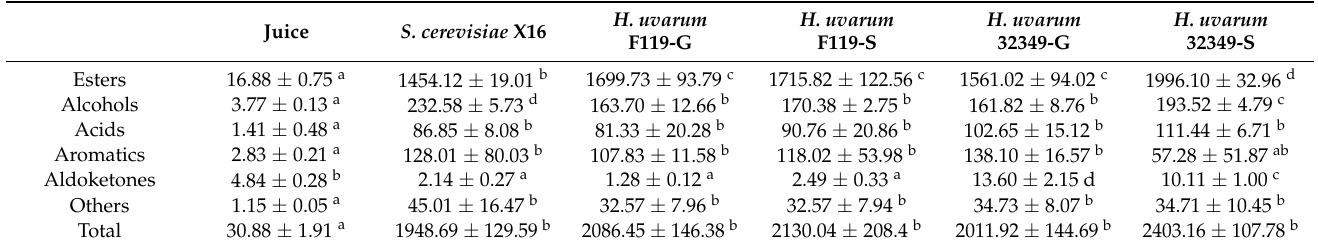
Figure 1. Types of volatile aroma compounds in juices and fermented wines of R. roxburghii , blueberry, and plum. ( A ) R. roxburghii juice and R. roxburghii fruit wine. ( B ) Blueberry juice and blueberry fruit wine. ( C ) Plum juice and plum fruit wine. Table 2. Volatile aroma compound content (mg/L) in R. roxburghii juice and R. roxburghii fruit